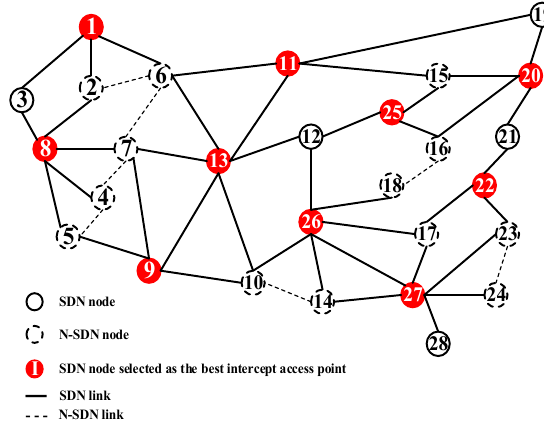
Figure 5. Hybrid SDN covered by minimum vertexes.